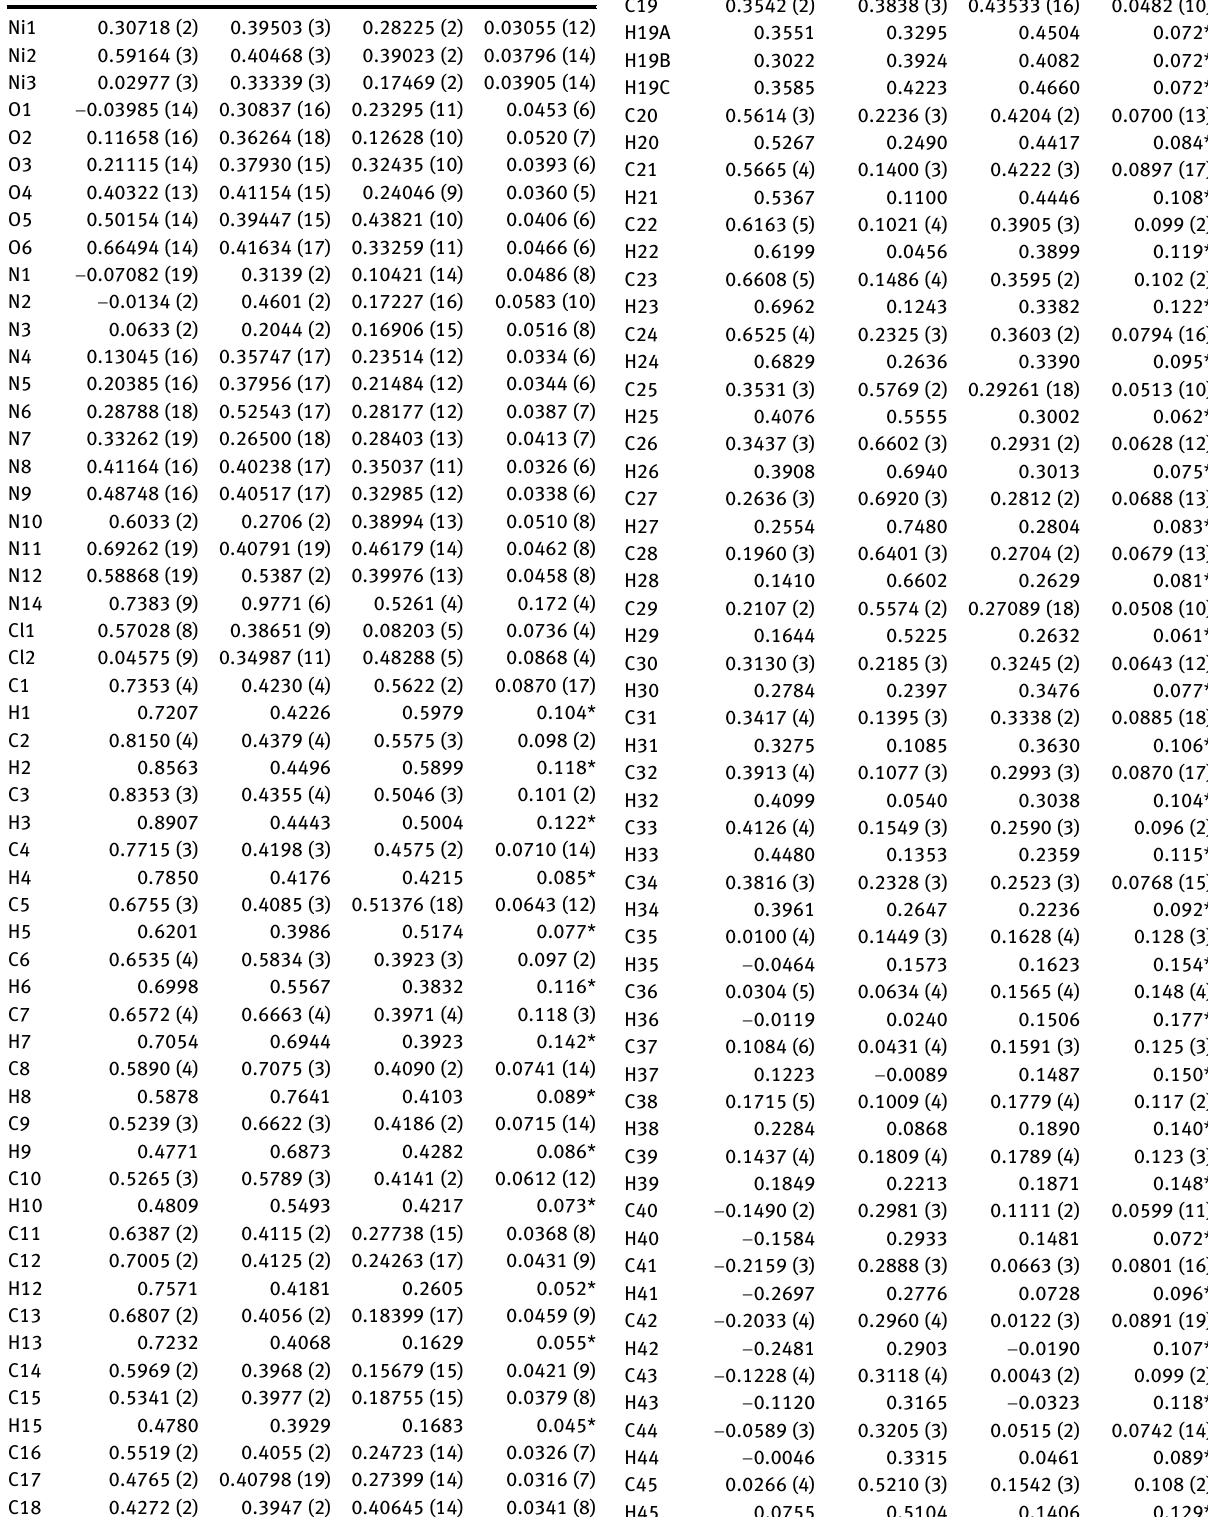
Table  : Fractional atomic coordinates and isotropic or equivalent isotropic displacement parameters (Å 